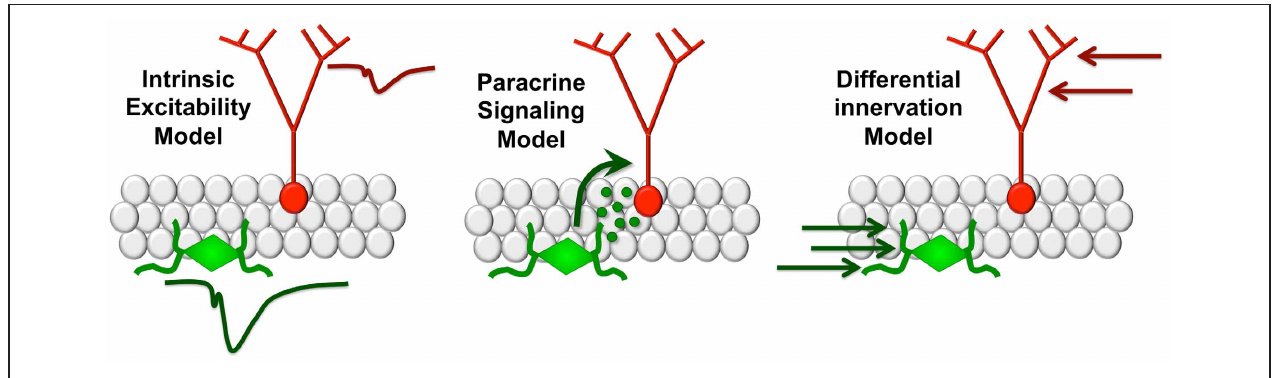
paracrine signaling model (center) , new neurons release signaling molecules that influence plasticity among mature granule cells. Under the differential innervation model (right) , new neurons respond differently due to distinct patterns of anatomical innervation by local